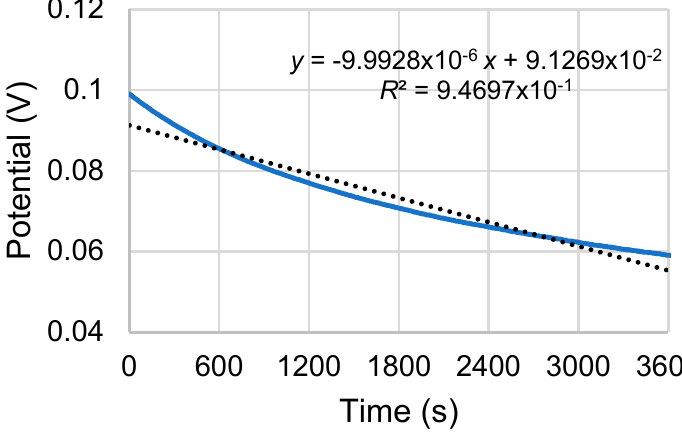
Figure 11. Drift for the Ag/AgCl RE.